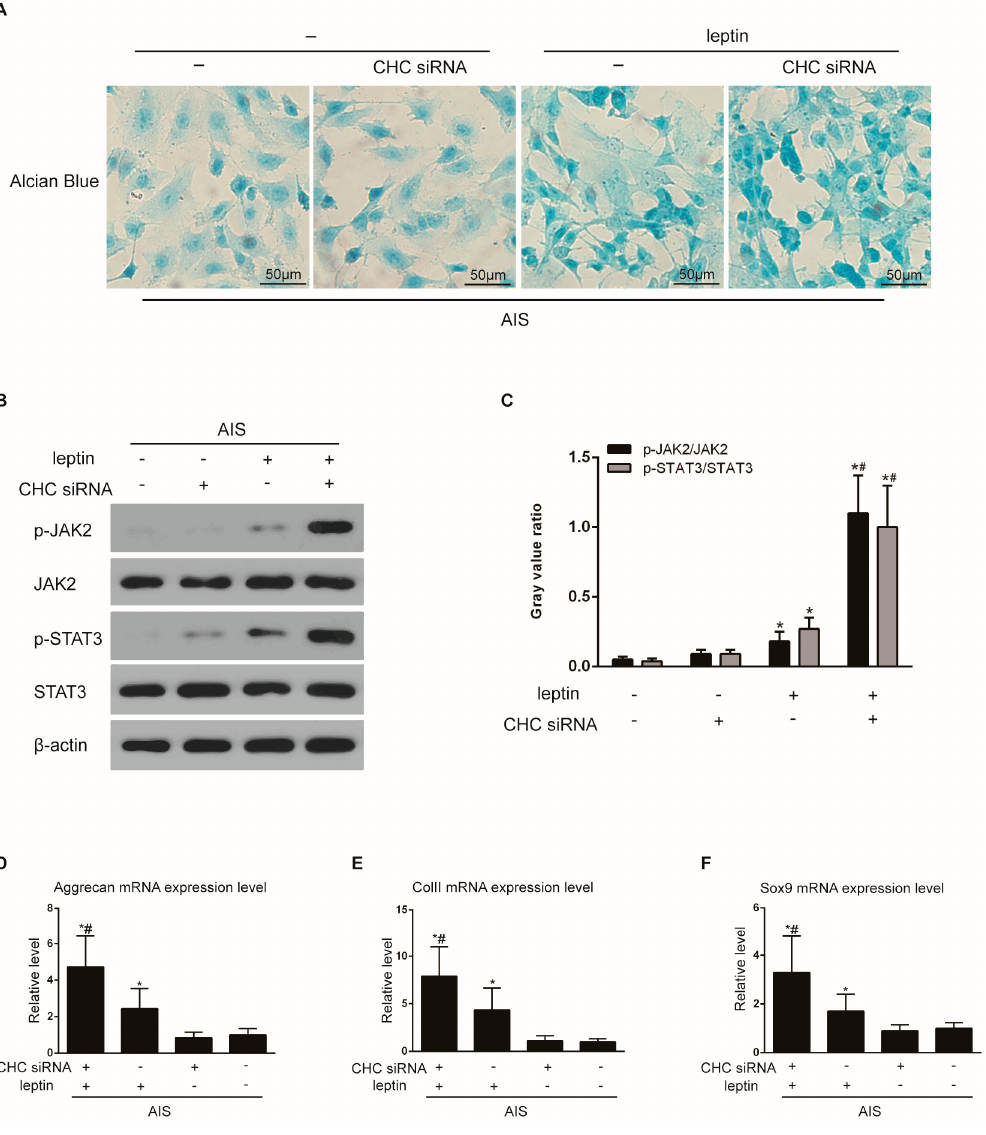
Figure 7. CHC knockdown enhances leptin’s effect on the chondrocytes from AIS patients. Chondrocytes from the AIS group were transfected with the control siRNA or CHC siRNA, followed by treatment with or without leptin (10 ng/mL) for 5 h. ( A ) The GAG content was visualized by Alcian blue staining. Stronger Alcian blue staining was observed in the leptin+CHC siRNA group than in the other group. Scale bars = 50 μ m; ( B ) Total proteins were extracted. The expression of p-JAK2, total JAK2, p-STAT3, and total STAT3 was analyzed by Western blotting. β -actin was used as an internal reference. Representative Western blots from three independent experiments are shown; ( C ) The relative quantitation of the p-JAK2/JAK2 and p-STAT3/STAT3 levels is shown in the graphs. * p < 0.05 vs. the group untreated with leptin or CHC siRNA; # p < 0.05 vs. the leptin-treated group; ( D – F ) Total RNAs were extracted from the chondrocytes. The relative mRNA expression of chondrogenic marker genes, including Aggrecan, ColII, and Sox9, was detected by quantitative real-time PCR. The Y axis represents the relative fold change in the transcript levels in the four groups. The untreated control group was set to 1.0. The data are displayed as the means ± SDs from 3 experiments. * p < 0.05 vs. the group untreated with leptin or CHC siRNA; # p < 0.05 vs. the leptin-treated group.